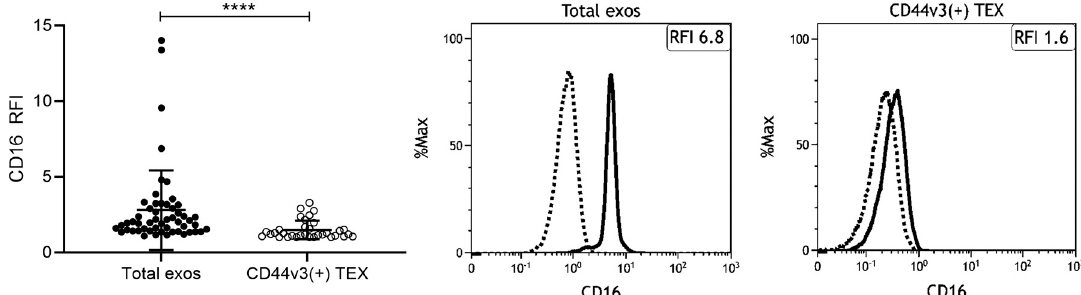
Figure 4. CD16 levels on plasma-derived exosomes from HNSCC patients. Total exosomes or CD44v3( + ) tumor-derived exosomes (TEX) isolated from plasma of HNSCC patients (n = 53 or n = 33) were stained for CD16. Surface levels as determined by on-bead flow cytometry are shown as RFI compared to an appropriate isotype control. Bars represent mean with SD. p values were determined by Mann–Whitney test, with **** corresponding to p ≤ 0.0001. Representative flow cytometry histograms depicting CD16 levels on total exosomes and CD44v3( + ) TEX are shown. The solid line represents the CD16 signal, the dashed line represents the isotype control.